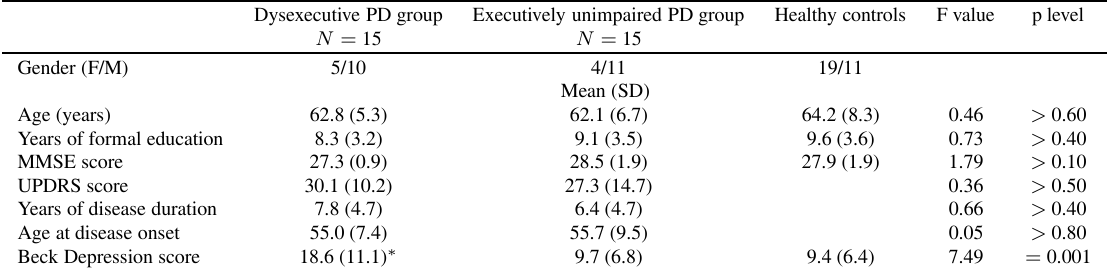
Table 1 Socio-demographic and clinical characteristics of participants in the PD and HC